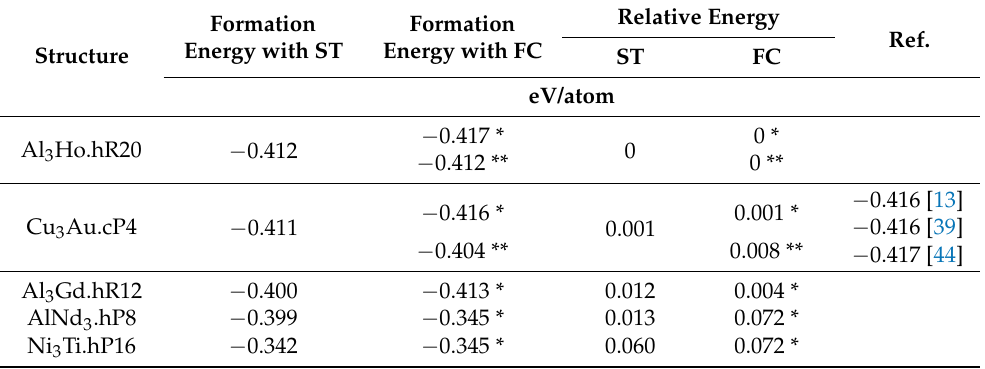
Table 2. TheformationenergyandotherpropertiesofAl 3 Erindifferentstructureswithdifferentpotentials.